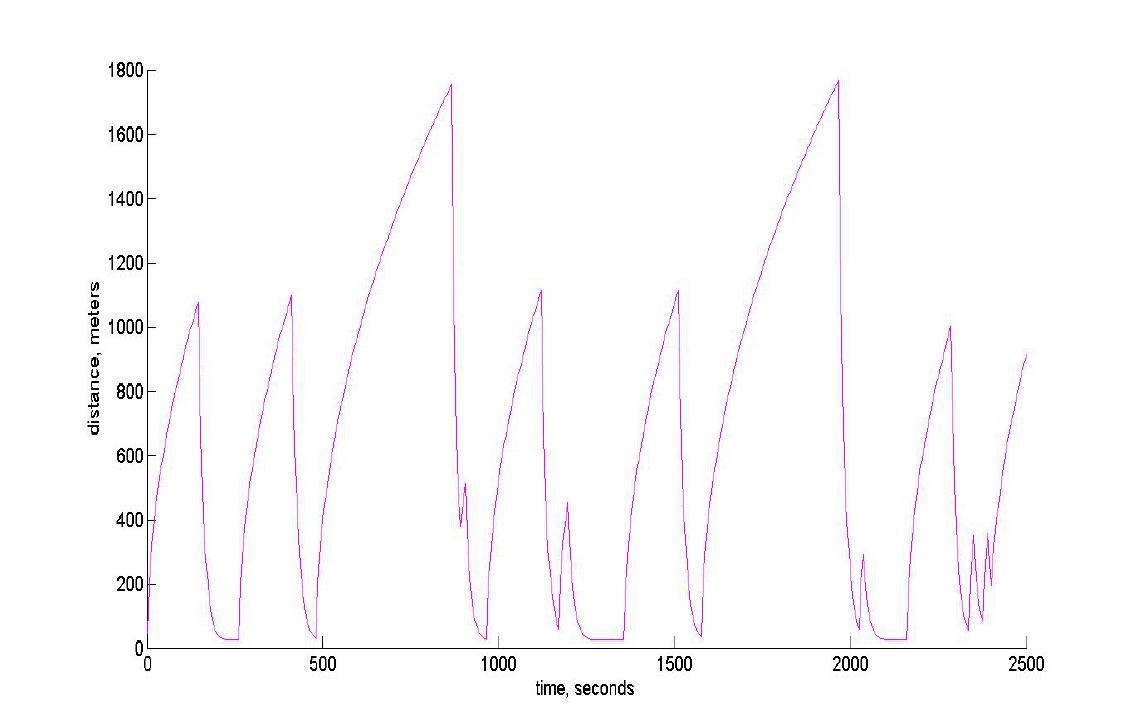
Figure 10. Averaged standard deviation of the position estimation error. The limit value in the observation areas is close to 24.5 m. One can see that in the areas of no observations, the SD monotonically